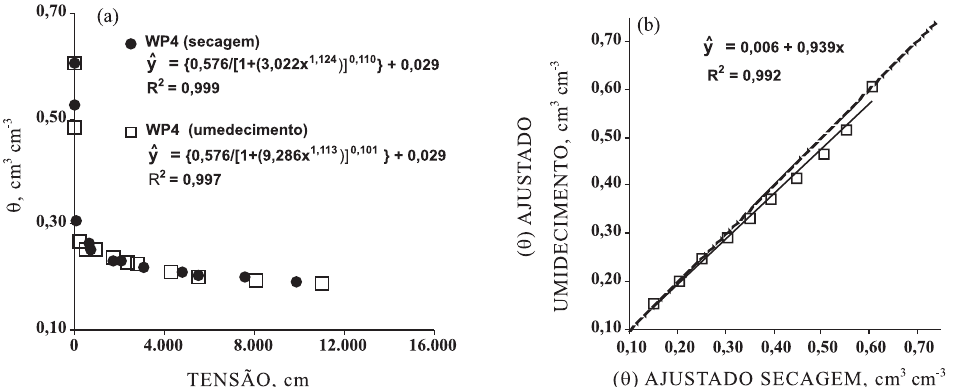
Figura 3. Dados observados de teor de água ( θθθθθ ) e respectivas curvas ajustadas de retenção de água no solo, pelo modelo de van Genuchten, obtido por um processo de secagem e umedecimento usando amostras deformadas e o método do WP4 (a); linha 1:1 tracejada e dados ajustados no intervalo de